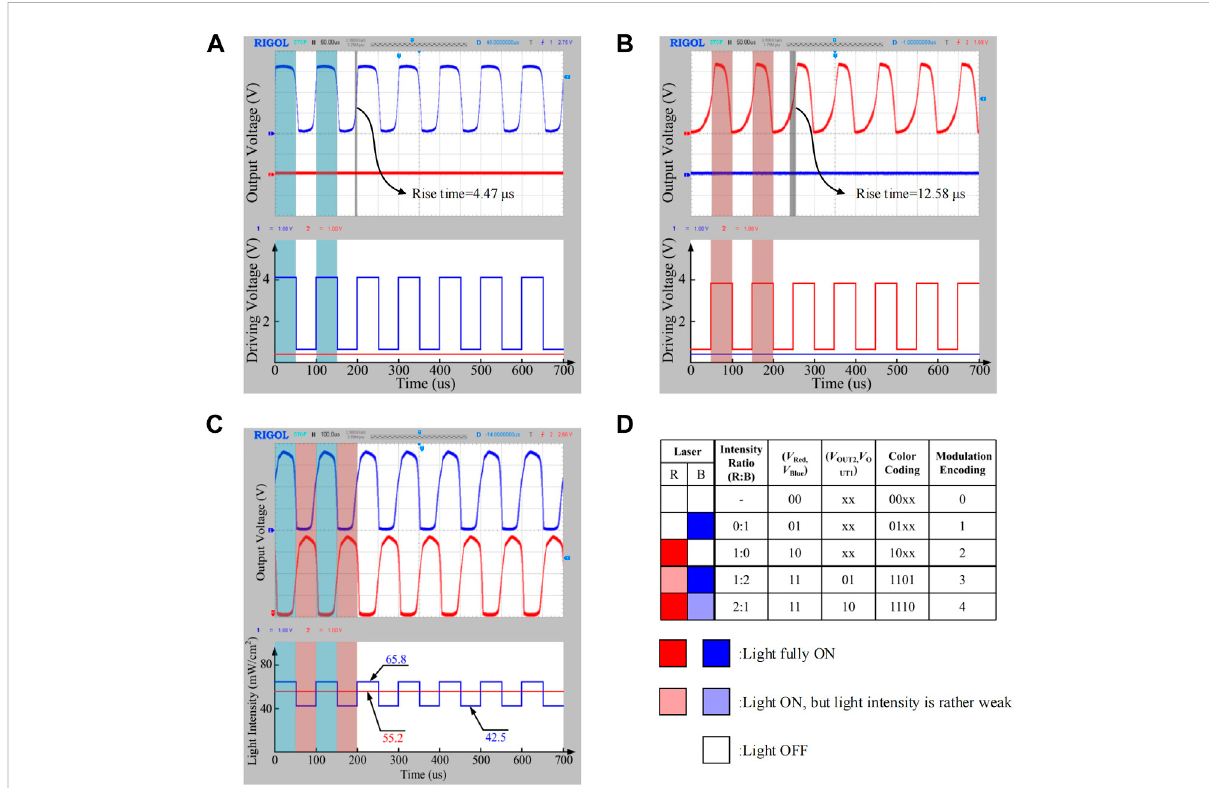
FIGURE 9 Dynamic recognition measurements of the color recognition unit. (A) Blue light: 10 kHz; (B) Red light: 10 kHz; (C) The red and blue light measurements; (D) The color coding of the cell. It can be seen that the receiver can shift its attention according to the change of green light. For further con fi rmation, it can recognize the on-off lights in different periods, and the results show the periodic changes of color connected with the incident light. When (VBlue, VRed)=(1,1), the optical receiver takes color as the data discrimination basis to achieve a higher-order signal modulation